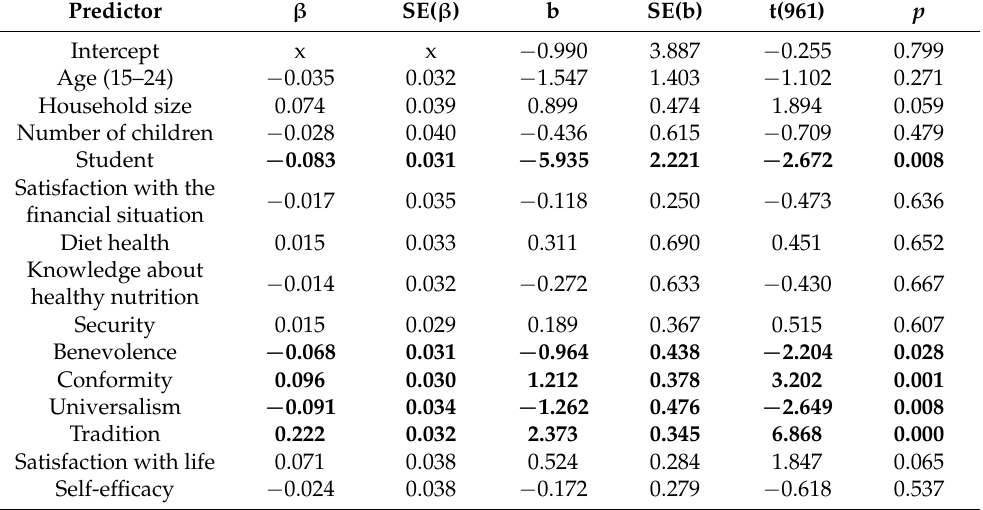
Table 3. Selected predictors of consumer ethnocentrism in the food market (a multiple regres- sion